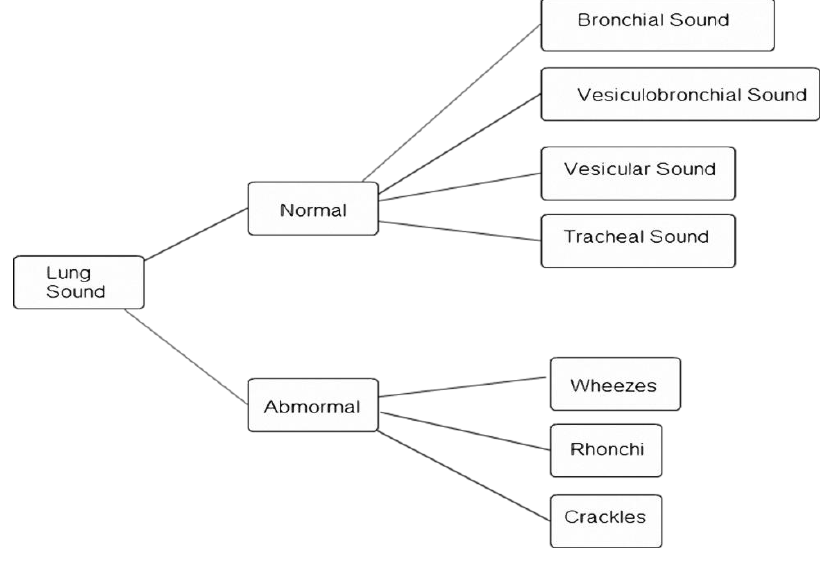
Figure 1. Lung sound classification